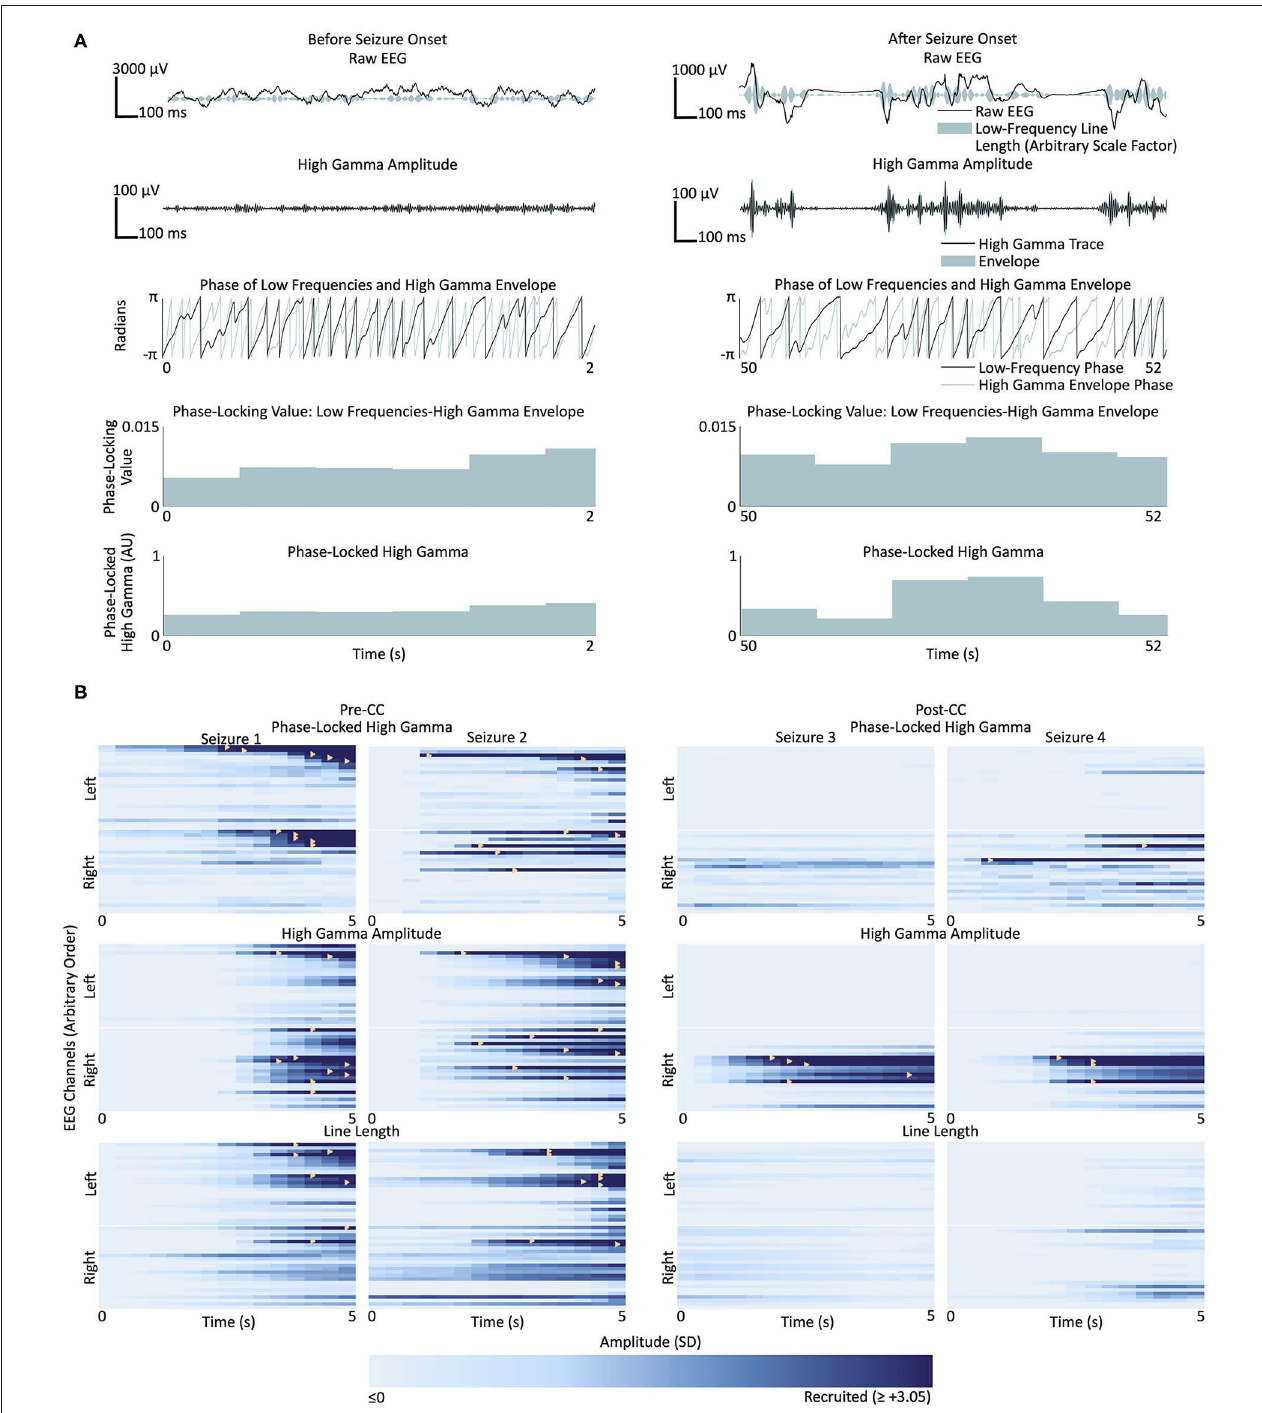
FIGURE 2 | (A) Representative phase-locked high gamma calculation from two sections of EEG from a single channel in Subject 1, before (left) and after (right) recruitment into Seizure 1. Top row: raw EEG in black, and low-frequency line length represented by breadth of teal shaded area; second row from top: signal filtered for high gamma (500th-order finite impulse response, 80–150Hz) in black, and envelope of the high gamma signal in teal; third row: instantaneous phase of the low frequency band (500th-order finite impulse response filter, 4–30Hz) in black, and high gamma envelope in teal; fourth row from top: phase-locking value between the low frequency signal and high gamma envelope; bottom row: phase-locked high gamma. (B) Seizures from Subject 1. Each box represents the time course of seizure evolution, showing phase-locked high gamma (top row), high gamma amplitude (second row) and low-frequency line length (bottom row), The left two columns represent the two seizures before corpus callosotomy (CC), and the right two columns represent the two post-CC seizures. Within each box, each horizontal bar